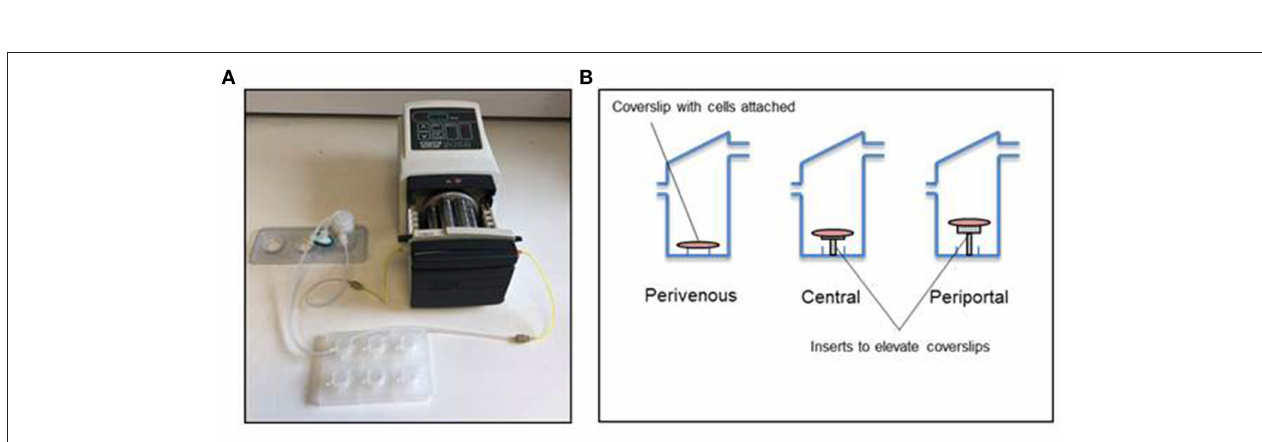
FIGURE 2 | Kirkstall QV-900 setup. (A) Kirkstall QV-900 plates are connected using Tygon silicone tubing to reservoir bottle (Kirkstall) and then connected to a multi-channel cassette pump (Watson-Marlow) using manifold tubing (Watson-Marlow). (B) Schematic of setup on the inside of the QV-900 wells.